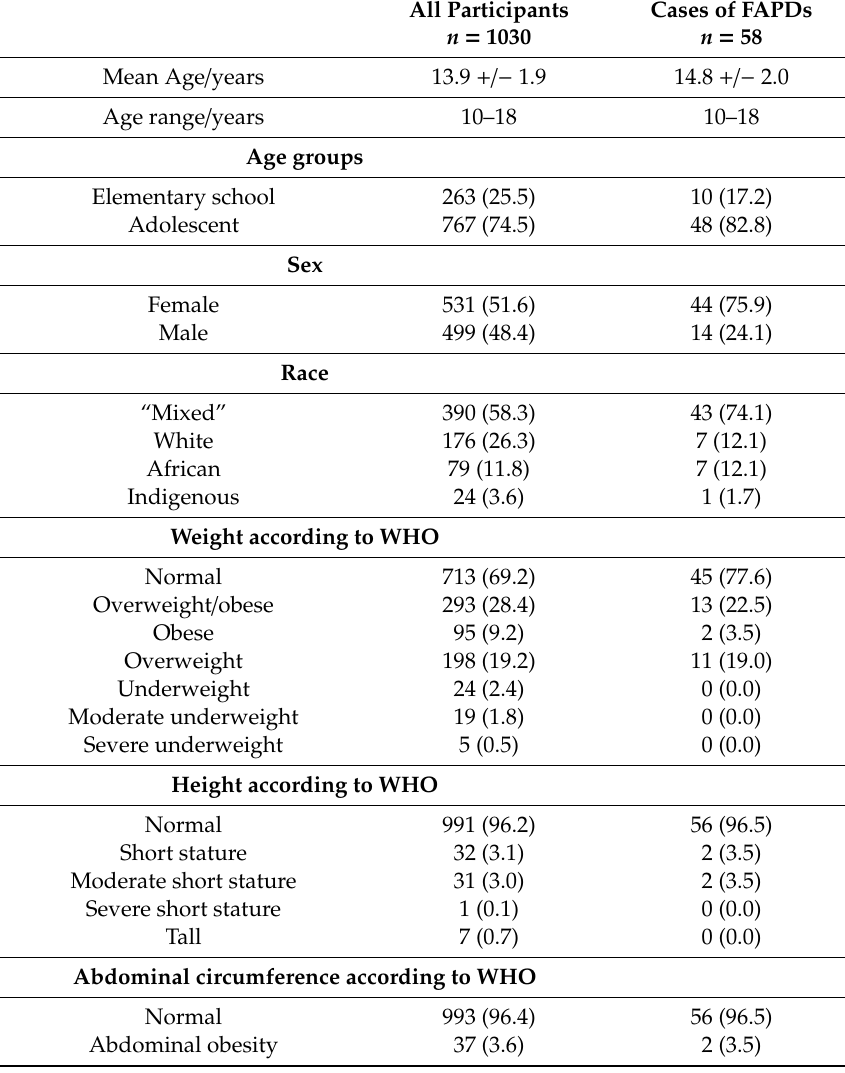
Table 1. Demographics of study participants and cases of